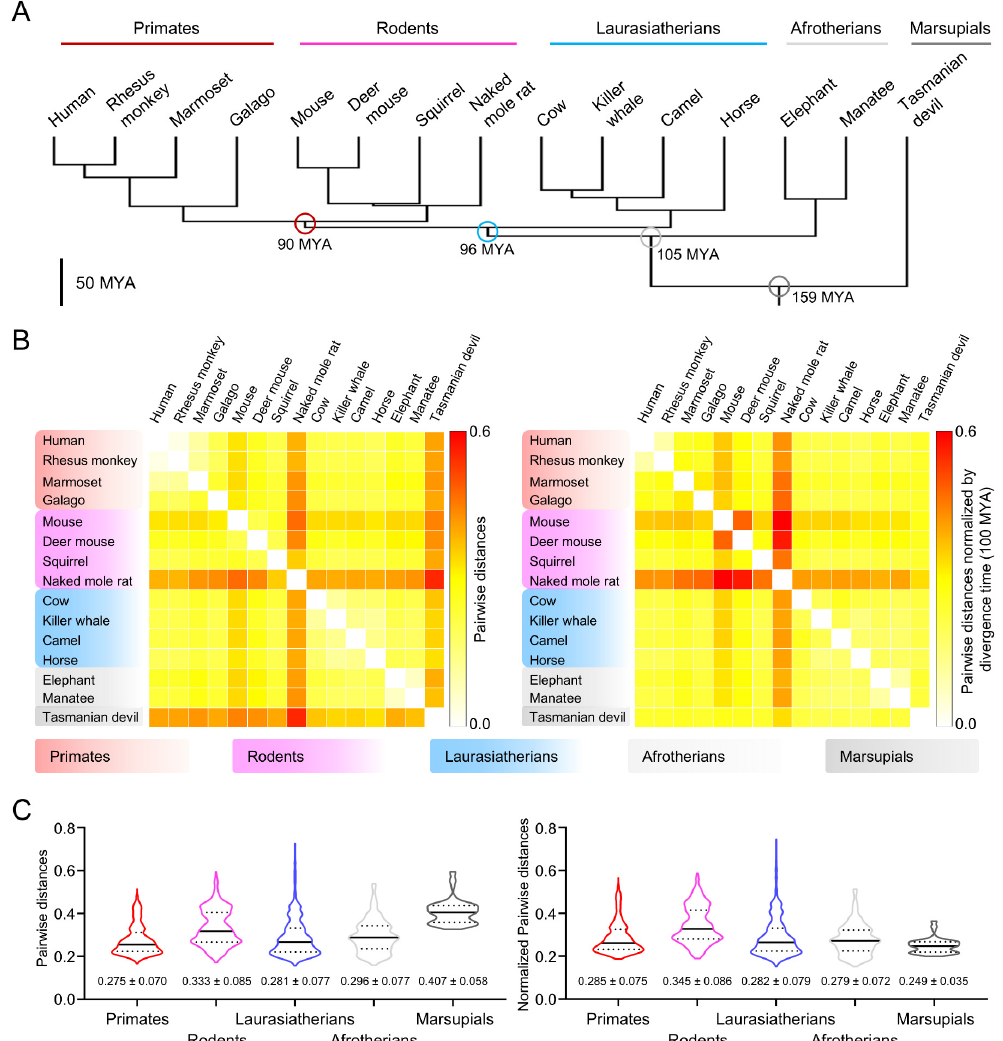
Figure 1. Amino acid sequence comparison of mammalian CatSper orthologs shows that CatSper channel components in marsupials evolved slowly. ( A ) A phylogenetic tree of placental mammals. Divergence times of the clades, primates (human, rhesus monkey, marmoset, and galago), rodents (mouse, deer mouse, squirrel, and naked mole rat), Laurasiatherians (cow, killer whale, camel, and horse), Afrotherians (elephant and manatee), and a marsupial (Tasmanian devil) are marked with circles. Million years ago, MYA. ( B ) Pairwise distance analysis of CatSper subunits between placental mammals. Concatenated protein sequences of CatSper subunits (CatSper1-2-3-4- β - γ - δ - ε - ζ -EFCAB9) were used to calculate the pairwise distances between species. Raw (left) and normalized (right) pairwise distances are represented with heatmaps. Values of the raw pairwise distances were normalized by divergence times between two species (100 MYA = 1). Pairwise distances over 0.6 were set to 0.6 (red). ( C ) Interclade comparison of the CatSper orthologs. Distributions of the raw (left) and normalized (right) pairwise distances between species in different clades were represented in violin plots. Solid and dotted lines in each plot indicate median and quartile values, respectively. Mean ± SD values for the raw and normalized pairwise distances were marked at the bottom of each column. See also Figure S1.